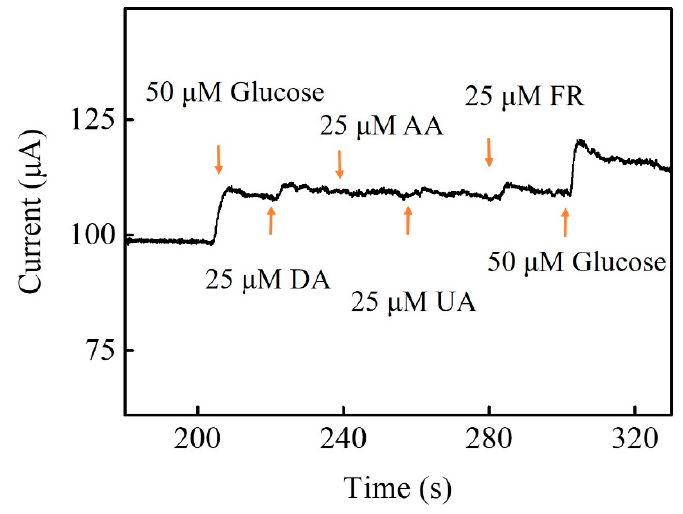
Figure 7. Interference tests of Zn-Co-S BHS/CNTs.